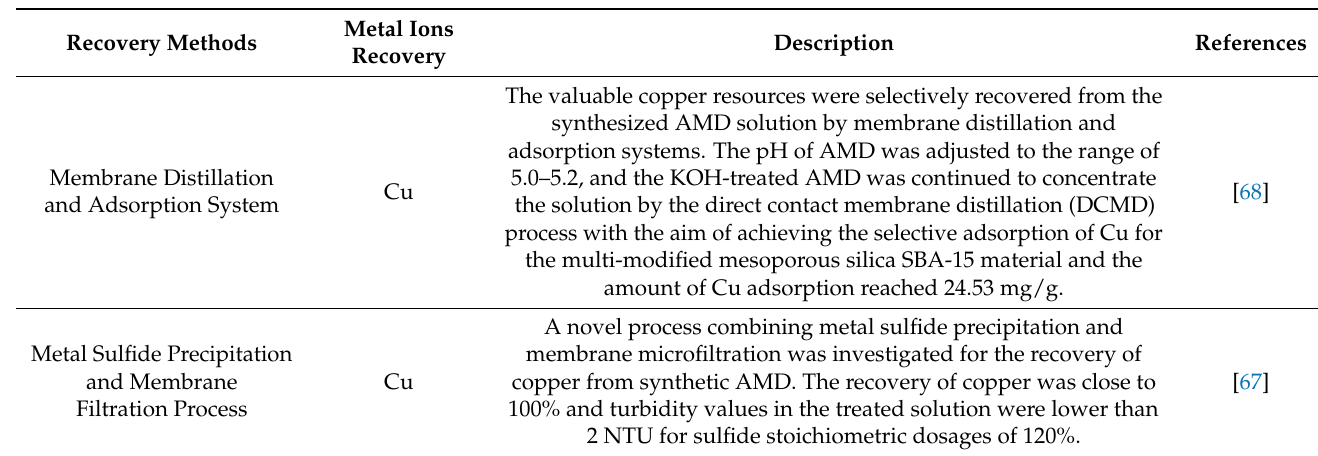
Table 2. Techniques for selective recovery of metal ions from